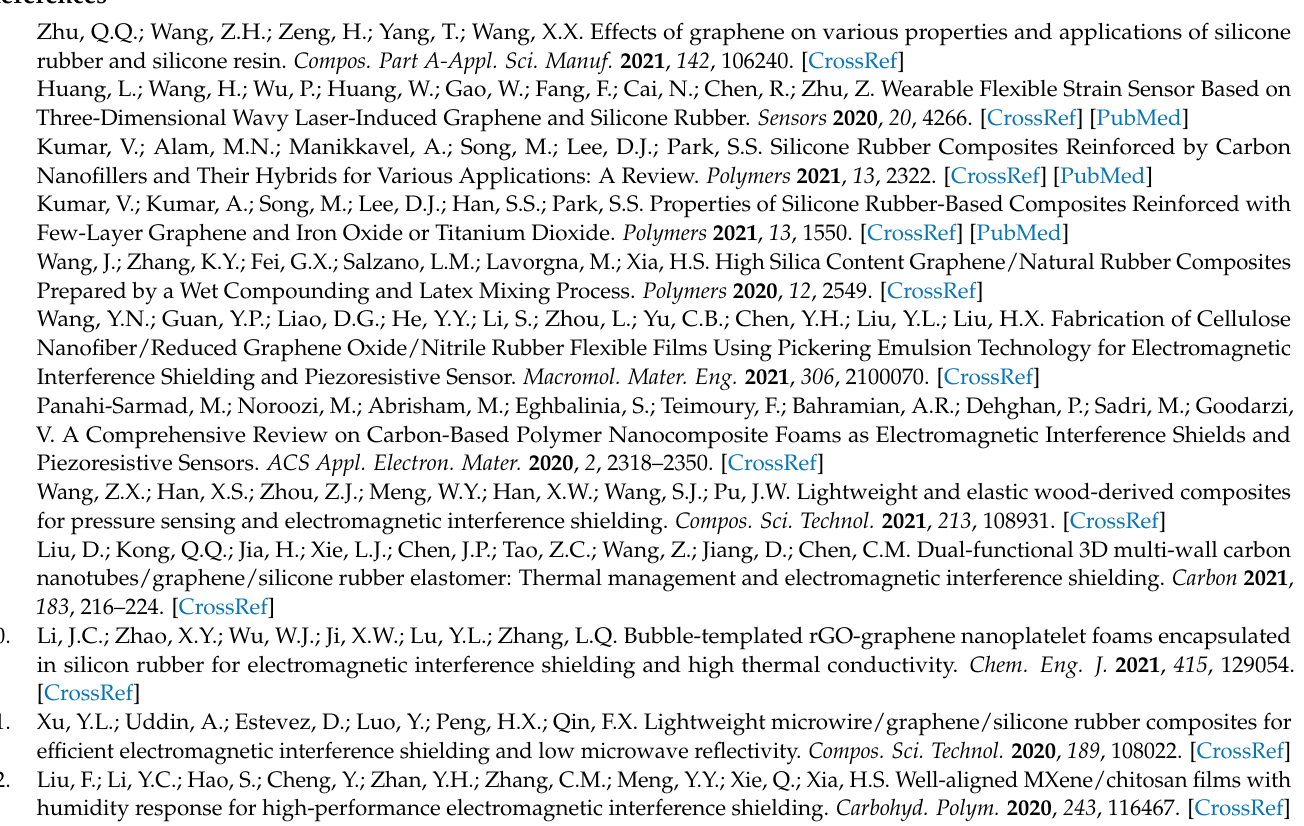
Figure S3. Effect of the thickness on the EMI SE of MGNR-6